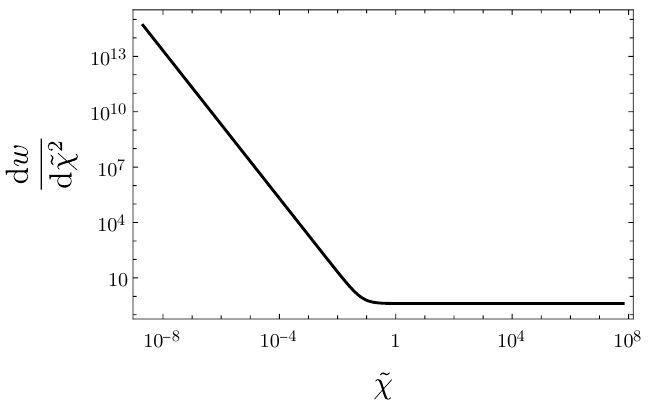
Figure 7 . Critical trajectory of d w/ d ˜ χ 2 as function of ˜ χ , for N S = 1 , N V = N F = 0